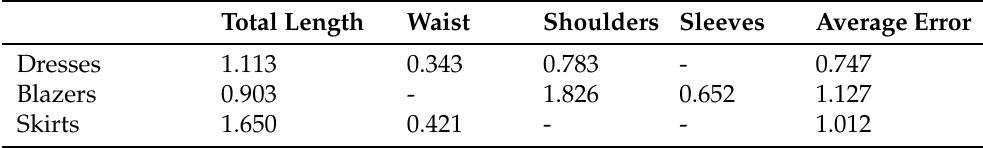
Table 3. Garment measurement errors given in